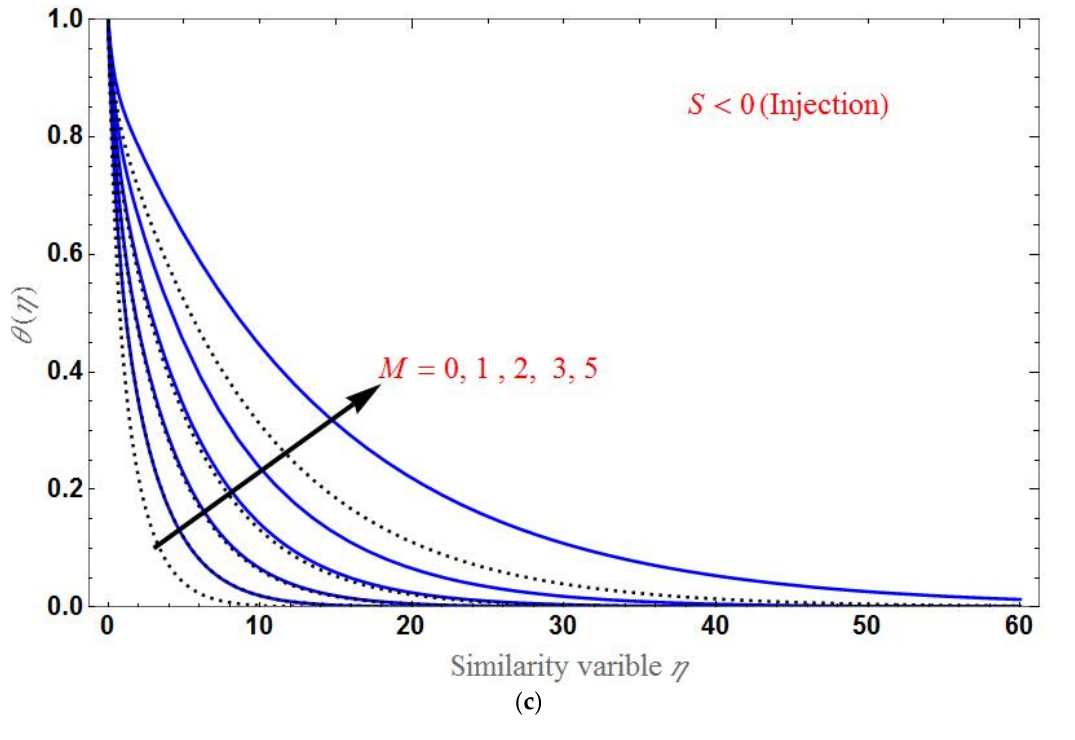
Figure 8. The temperature profile θ ( η ) as a function of η for several values of M and for three different regimes of S : ( a ) S = 0, ( b ) S = 1, and ( c ) S = − 1. The other fixed parameters are: 1 Λ = Da − 1 = N = 1, φ = 0.1, φ = 1, 0.1, 0.04. Da R 2 1 R 1 2